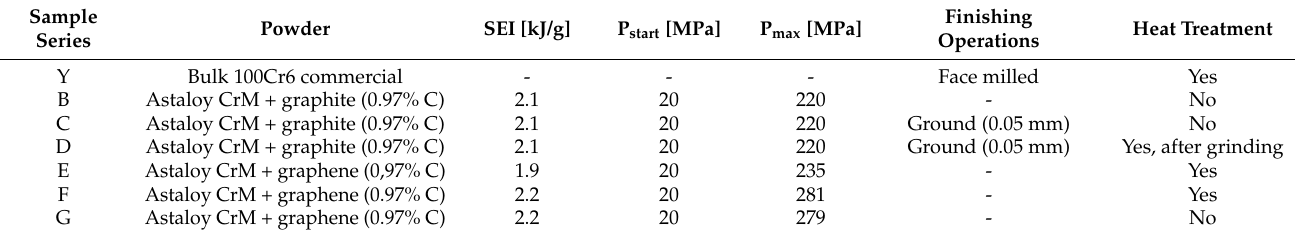
Table 2. Process parameters and post–sintering treatments were employed in this